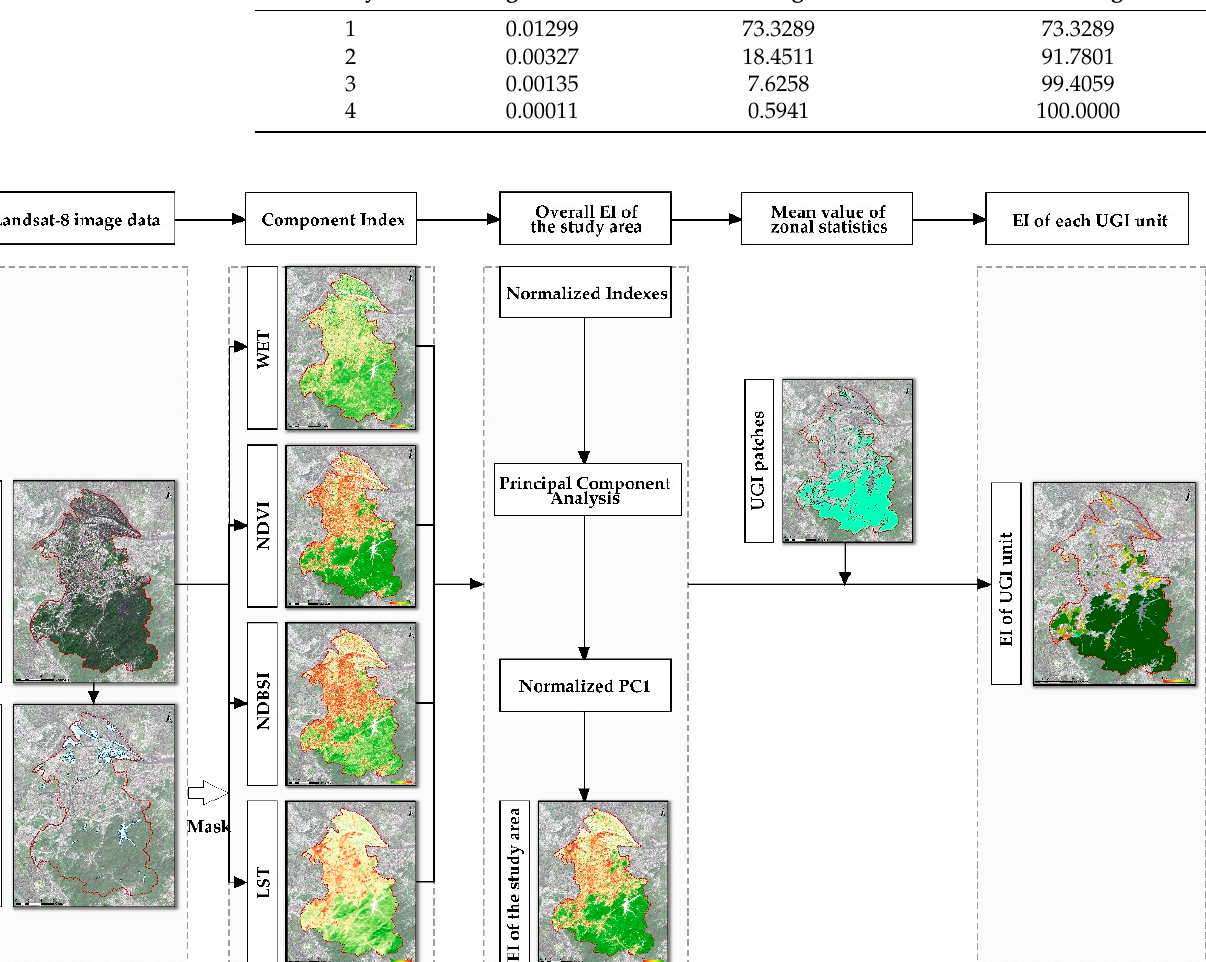
Figure 5. Flowchart of EI analysis.